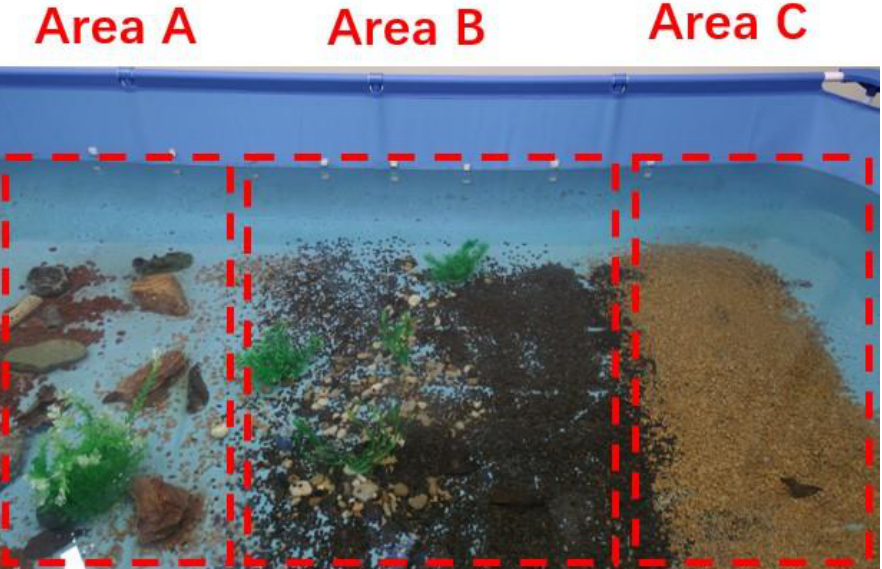
Figure 6. There are three areas in the underwater data acquisition pool, and different areas contain different levels of texture [9]. Table 7. The Absolute Pose Error (APE) of the original algorithm is compared with that of the im- proved algorithm in the underwater dataset. (Unit: meter).